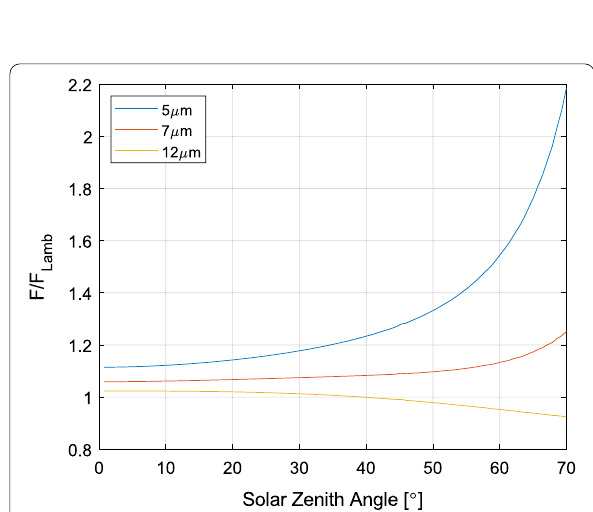
∂ T π , σ B ε T 4 = ( 1 − A ) S + Ŵ (1) (cid:31) ∂ z ′ (cid:30) P z ′ = 0 (cid:30) (cid:30) (cid:30) Fig. 4 Thermal conductivity as a function of temperature as derived for different small bodies. Data for C-class asteroids Bennu (Emery et al. 2014; Dellagiustina et al. 2019; Rozitis et al. 2019) and Ryugu (Müller et al. 2017; Hamm et al. 2020), for average near-Earth asteroids (Delbo et al. 2007), for comets 9P/Tempel 1 (Groussin et al. 2013; Davidsson et al. 2009), 103P/Hartley (Groussin et al. 2013), and 67P/ Churyumov–Gerasimenko (Spohn et al. 2015), for S-class asteroids Itokawa (Fujiwara et al. 2006) and Eros (Lebofsky and Rieke 1979; Harris and Davies 1999) are shown together with the current best = k ρ c p (2) Ŵ estimate for Phobos (Kuzmin and Zabalueva 2003). For comparison, (cid:31) the thermal conductivity of the lunar regolith (Hayne et al. 2017) is also given